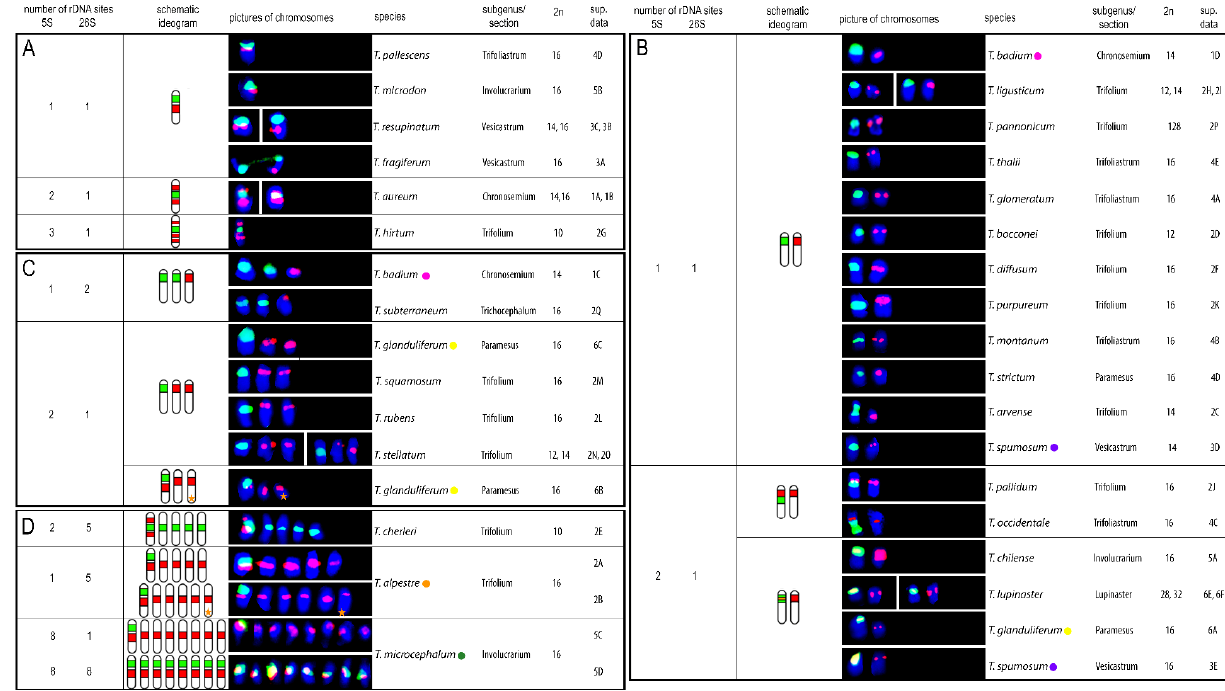
Figure 1. Hybridization patterns of 5S (red) and 26S (green) rDNA FISH probes in 30 Trifolium species. Distribution of all rDNA loci on 1 chromosome ( A ), 2 chromosomes ( B ), 3 chromosomes ( C ), and 5 and 8 chromosomes ( D ) per haploid genome was observed. A star (columns 2 and 3) indicates an odd chromosome carrying signal. A coloured circle next to a species name indicates variability in rDNA sites number and localization. Fluorescent probes were labelled with digoxigenin visualized by anti ‐ DIG ‐ FITC antibodies (green) or biotin visualized by streptavidin ‐ Cy3 antibodies (red). Note that ideograms only schematically illustrate numbers of 5S and 26S rDNA loci and their mutual localization and do not precisely capture specific chromosomal localization of each locus.